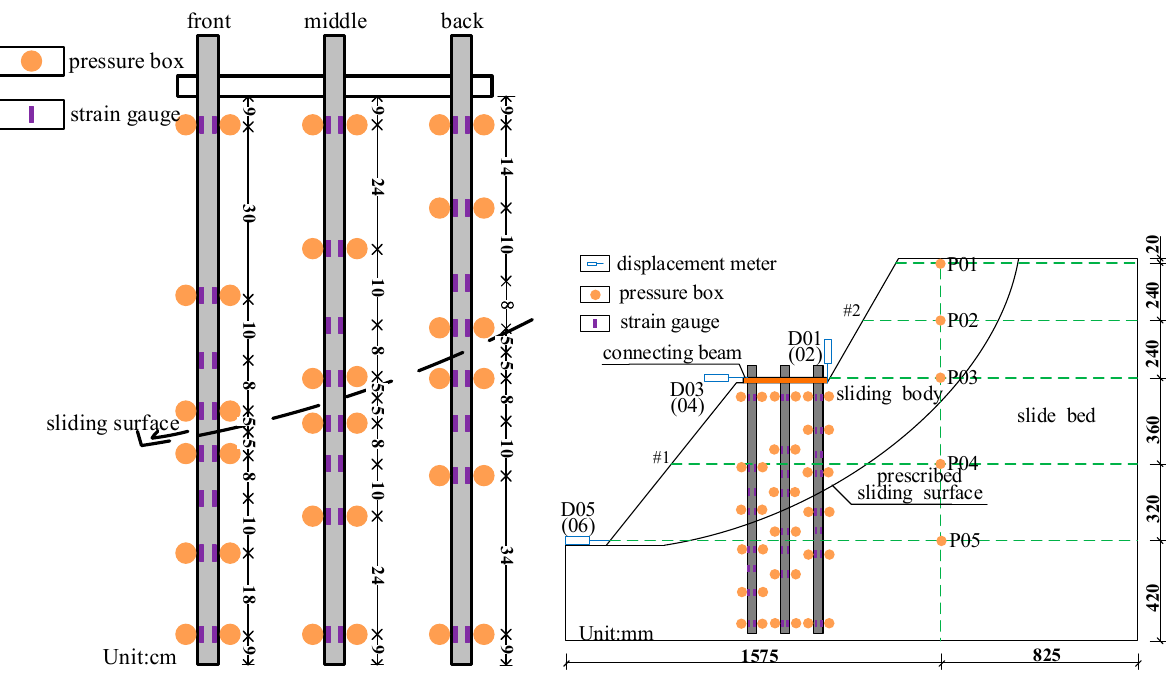
Figure 8. The layout of the test components (unit: mm).